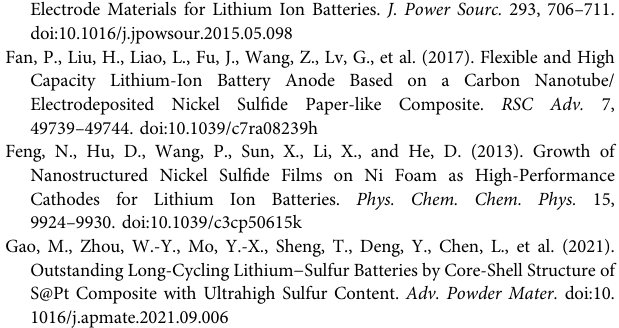
the proportions of capacitance effect and ion diffusion in current contribution at different sweep rates. The current contribution proportion of capacitance effect increases from 59.4 to 85.2% with the increases of sweep rate from 0.1 mV s − 1 to 1.5 mV s − 1 . The large current contribution of the capacitance effect also shows that NiS nanosphere electrodes have good rate capability. Two cells in series were used to light up the LED lamps of “ NiS ” , as shown in Figure 7 , which indicates the potential application of NiS nanosphere material as anode for LIBs.